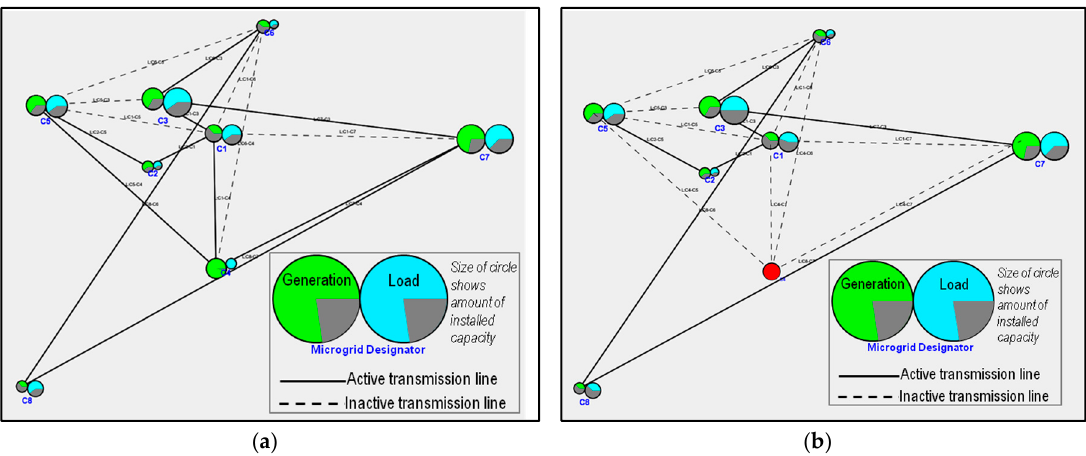
Figure 22. ( a ) The simulated power system prior to emergency (all MGs are healthy); and ( b ) the simulated system in restored condition (the faulty MG has been removed.).